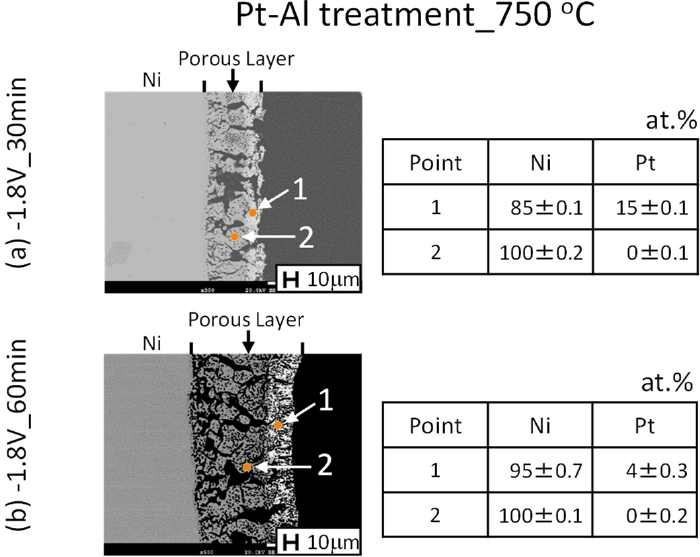
Figure 8. Cross-sectional microstructure and point analysis results of the sample Al-deposited and Al-dissolved under ( a ) − 1.8 V for 30 min and ( b ) − 1.8V for 60 min each condition after Pt.